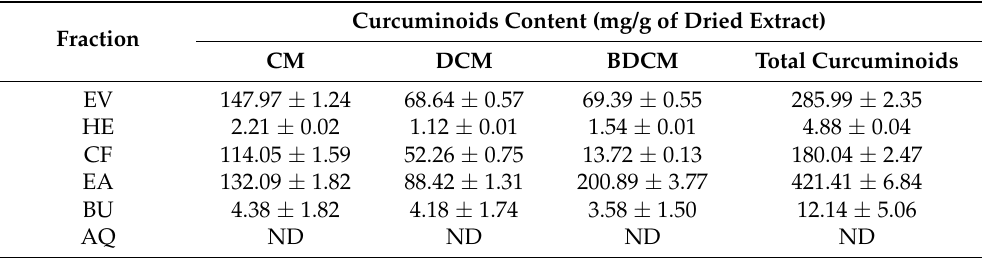
Table 1. Curcuminoids content of turmeric rhizome fractions analyzed by HPLC (Mean ± SD, n = 3).